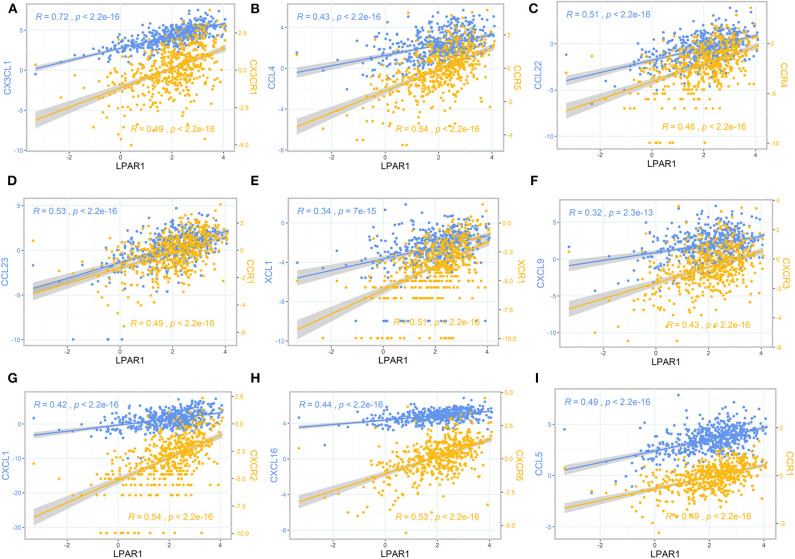
The scatter plot and correlation curve of lysophosphatidic acid receptor 1 (LPAR1), chemokines, and chemokine receptors. (A–I) LPAR1 was positively associated with CX3CL1, CX3CR1, CCL4, CCR5, CCL22, CCR4, CCL23, CCR1, XCL1, XCR1, CXCL9, CXCR3, CXCL1, CXCR2, CXCL16, CXCR6, CCL5, and CCR1. CCL, CC chemokine ligand; CCR, CC chemokine receptor; CXCR, CXC chemokine receptor; CXCL, CXC chemokine ligand; XCL, C chemokine ligand; XCR, C chemokine receptor; CX3CL, CX3C chemokine ligand; CX3CR, CX3C chemokine receptor.